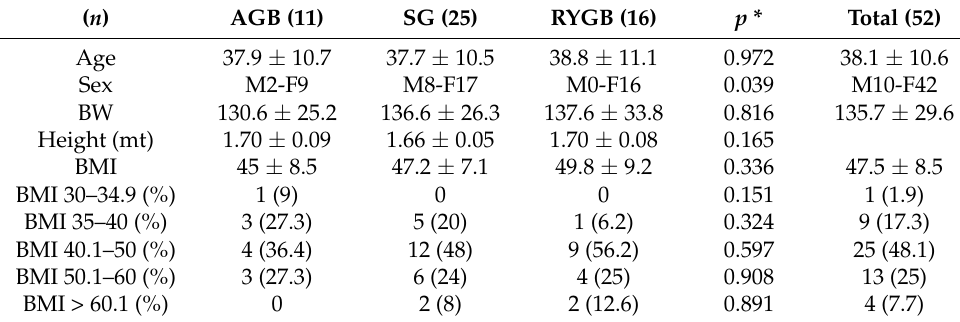
Table 1. Clinical characteristics of the subjects before the